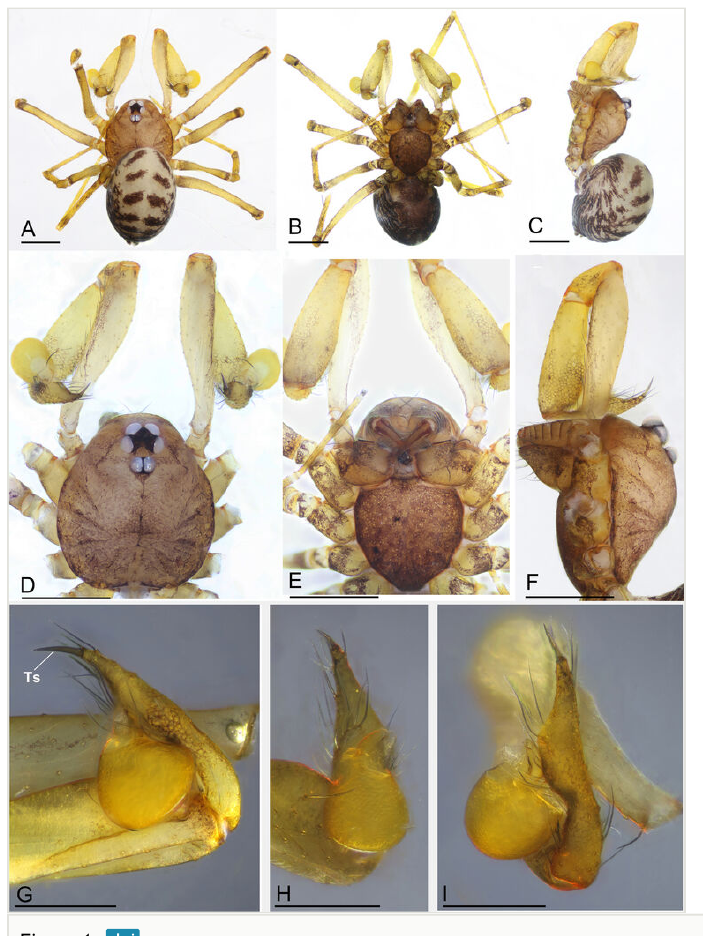
Figure 1. Yueleptoneta dongxing sp. n., holotype male. A habitus, dorsal view; B habitus, ventral view; C habitus, lateral view; D prosoma, dorsal view; E prosoma, ventral view; F prosoma, lateral view; G left palp, retrolateral view; H left palp, ventral view; I left palp, dorsal view. Abbreviation: Ts = tarsal spur. Scale bars: 0.4 mm (A–F) and 0.2 mm